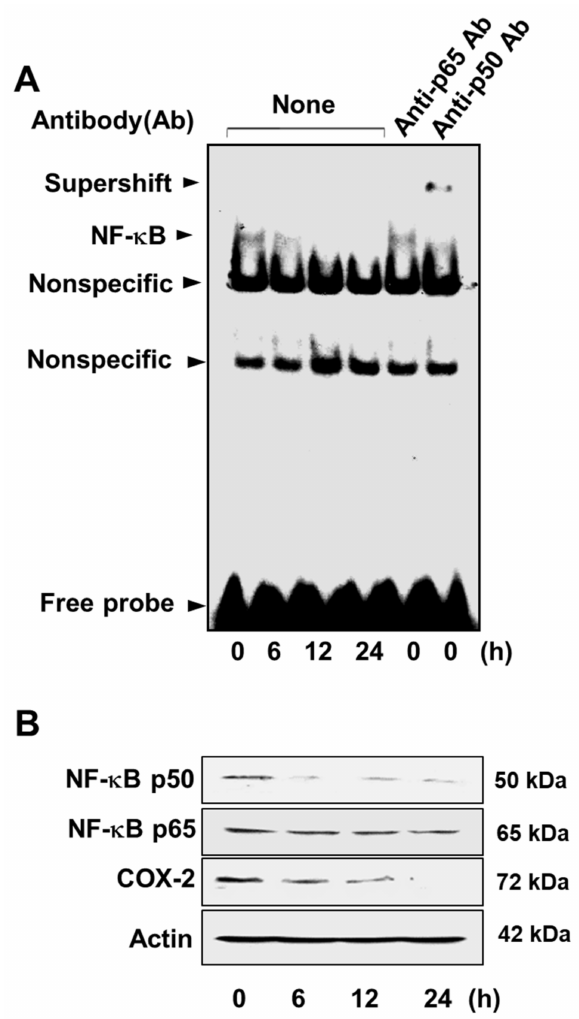
Figure 7. Lycopene decreases the DNA-binding activity of nuclear factor-kappa-light-chain-enhancer of activated B cells (NF- κ B) and the levels of NF- κ B subunit p50 and cyclooxygenase-2 (COX-2). The cells were treated with 2 µ M lycopene for the indicated time periods. ( A ) DNA-binding activity of NF- κ B in the nuclear extracts was determined by electrophoretic mobility shift assay. Antibodies (Ab) against the NF- κ B subunits p50 and p65 were added to the nuclear extracts for the supershift assay (columns 5 and 6). “None” Ab means that no antibodies were added to the nuclear extracts (columns 1–4). ( B ) The levels of the NF- κ B subunits p50 and p65 and of COX-2 in whole-cell extracts were examined by Western blot analysis. Actin was used as a loading control. “Nonspecific” means nonspecific